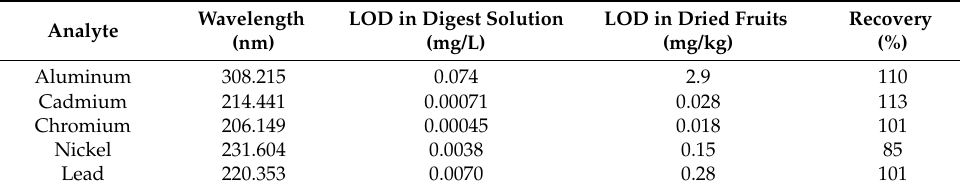
Table 2. Characteristics of the analytical method.